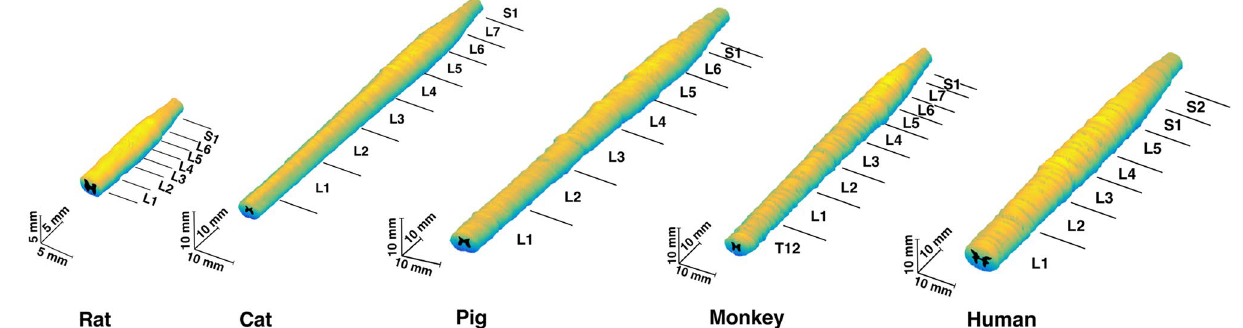
Figure 5. 3D model of the lumbosacral spinal cords of the rat, cat, pig, monkey, and human. 3D models were reconstructed based on the acquired MRIs from a representative animal (n = 1) per species. Annotations show the segments of the spinal cord identified using the method shown in Fig.